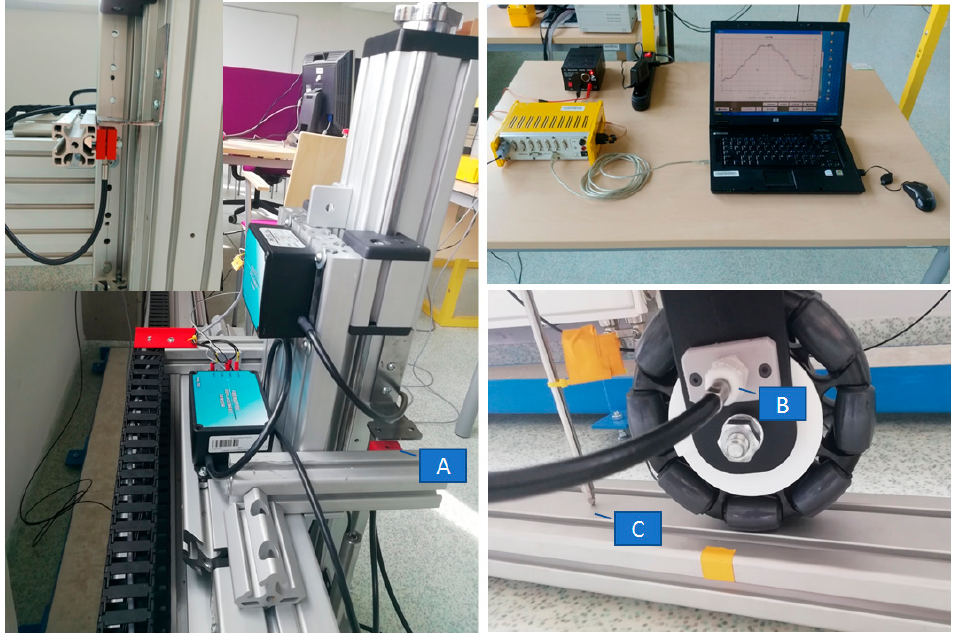
Figure 6. Position of the measuring instrumentation. ( A ) optical sensors, ( B ) optical sensors, ( C ) LVDT displacement sen- sor.